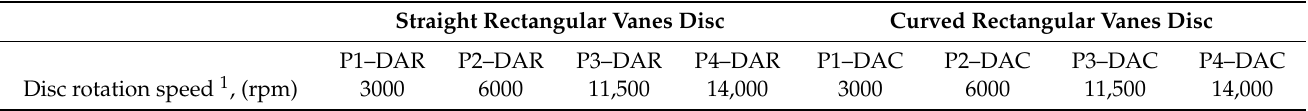
Table A1. Atomization parameters established in the experiments with a flow rate of 0.4 cm 3 /s. Straight Rectangular Vanes Disc